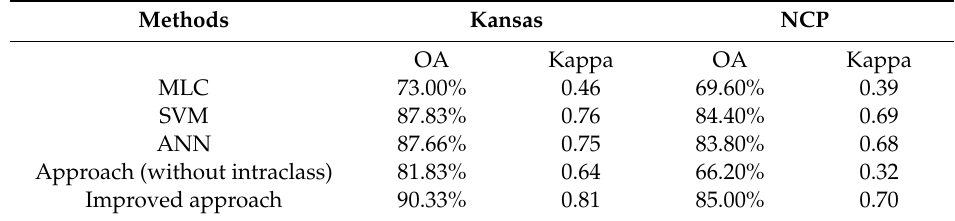
Table 11. Comparisons of overall accuracies between di ff erent methods using confusion matrix. Approach (without intraclass) does not consider the intraclass